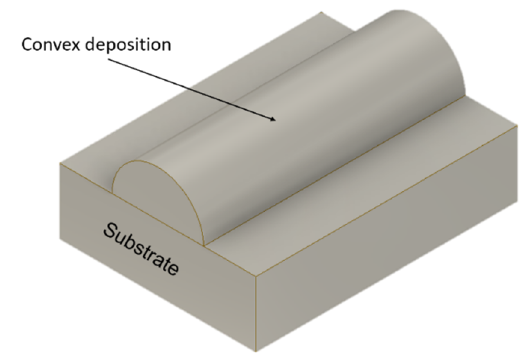
Figure 3. Convex shaped deposition at substrate’s surface.